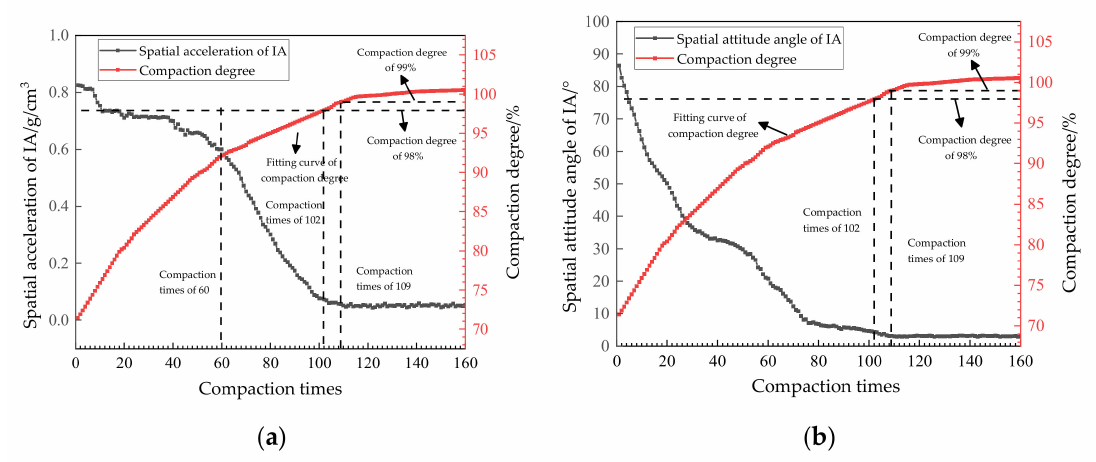
Figure 11. The relationship between the IA motion data and compaction parameters in the SMA-25 asphalt mixture. Spatial acceleration ( a ) and spatial attitude angle ( b ) of the IA in the SMA-25 asphalt